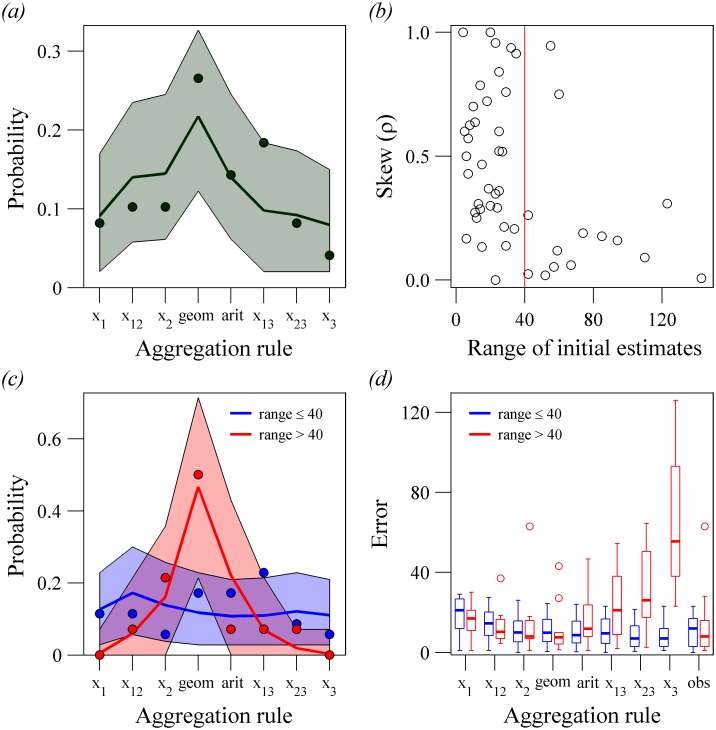
The use and consequences of different aggregation rules in Experiment 1.(a) Probability of each aggregation rule being the closest to the observed consensus estimates of the groups (filled circles). Also plotted is the probability (mean is black line, and shaded region is 95% confidence intervals) that the aggregation rule is the closest to the observed consensus estimates when a ‘noisy’ geometric mean simulation is instead used to aggregate the initial estimates (S1 Methods). (b) Range and skew in initial estimates for each group. The range of initial estimates is plotted against the relative distribution of the estimates. Skew is ρ = (x2−x1)/(x3−x1), and is close to zero if the highest estimate (x3) is a relative outlier, and close to one if lower estimate (x1) is a relative outlier. The threshold between groups of low and high range (red line) is an approximate point that separates the region with any configuration (≤40) to the region with the two lower estimates being much closer to each other than to the higher (>40). (c) As (a), but separately for groups with a low range of estimates (blue dots, line and shaded area) and high range of estimates (red dots, line and shaded area). (d) Absolute error if each of the strategies had been followed exactly by groups with low range (blue) and high range (red). The notation for strategies as in Fig 4, with a final column added in (d) for the error of the observed group consensus estimates. The threshold used to define groups with low and high ranges did not have any effect on the trends in (c) and (d) (S6 Fig). The box plots show the median (thick black lines), interquartile range (enclosed by the boxes), 1.5 × the interquartile range beyond the boxes (whiskers) and outliers beyond the whiskers (open circles).